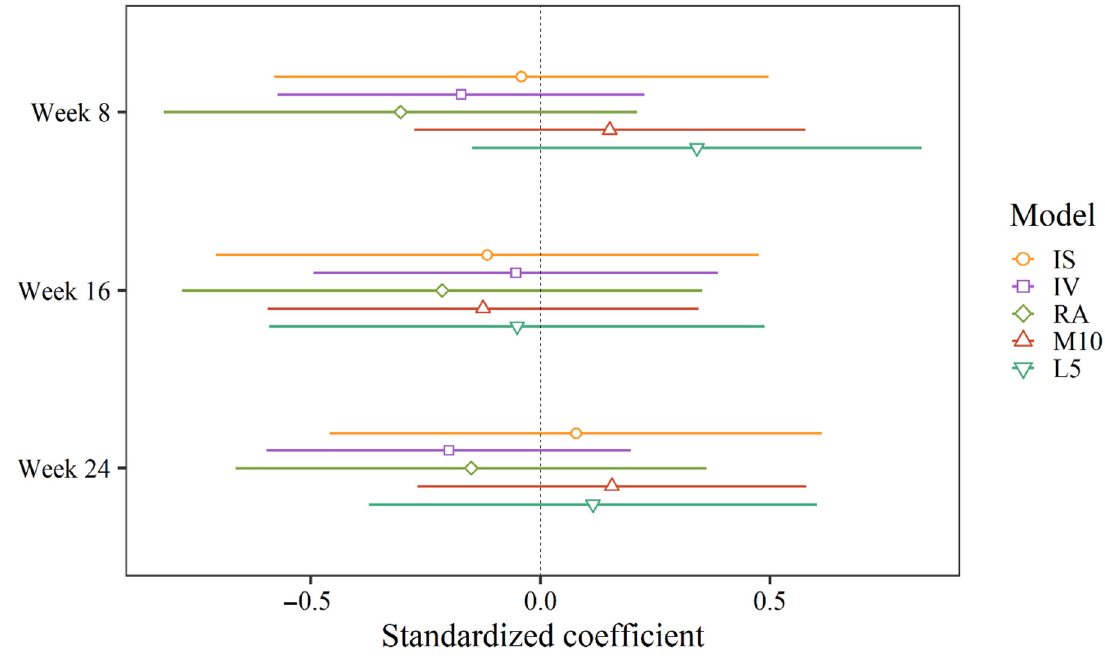
relative to the control group) for the extended cosine model.